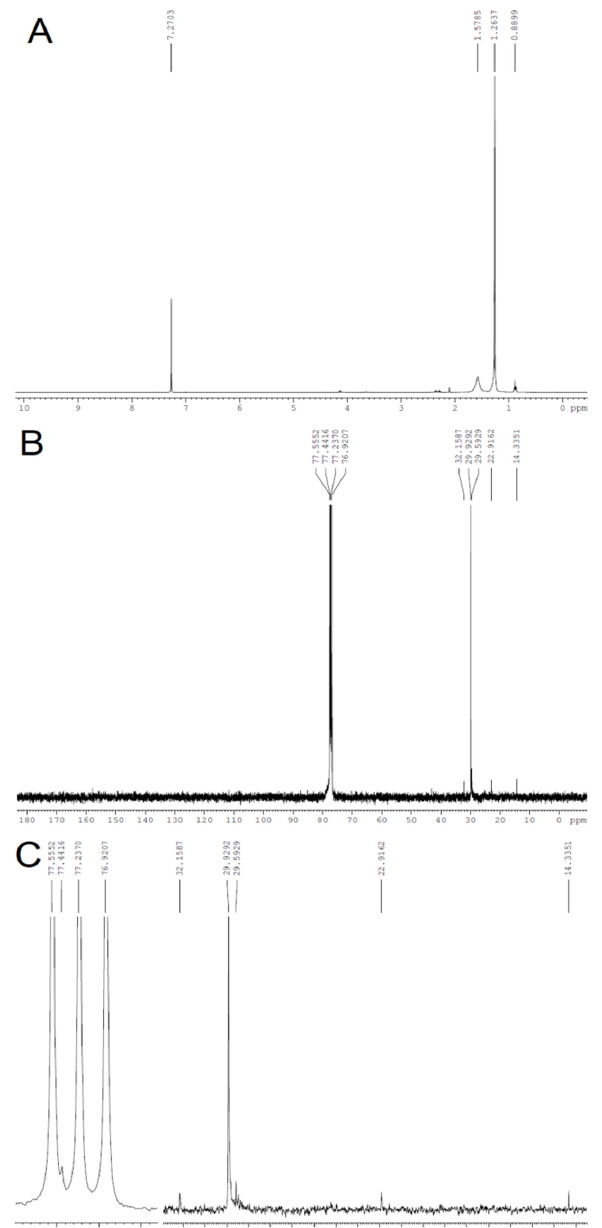
Figure7. 1 H( A ), 13 C( B )andamplified 13 C-NMR( C )spectraofcelluloseobtainedfrom Opuntiaficus-indica Figure 7. 1 H ( A ), 13 C ( B ) and amplified 13 C ‐ NMR ( C ) spectra of cellulose obtained from Opuntia ficus ‐ indica L. Miller . L.